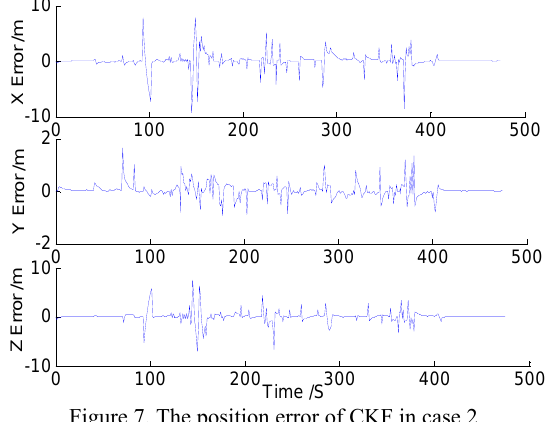
Figure 7. The position error of CKF in case 2